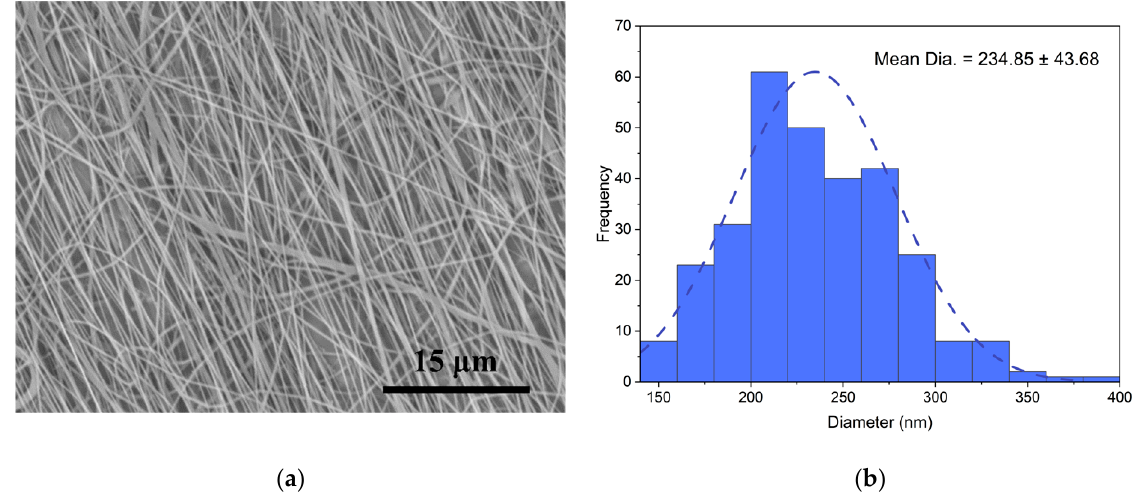
Figure 4. ( a ) Morphology of the PA6 nanofibers. ( b ) Diameter distribution of the PA6 nanofibers.